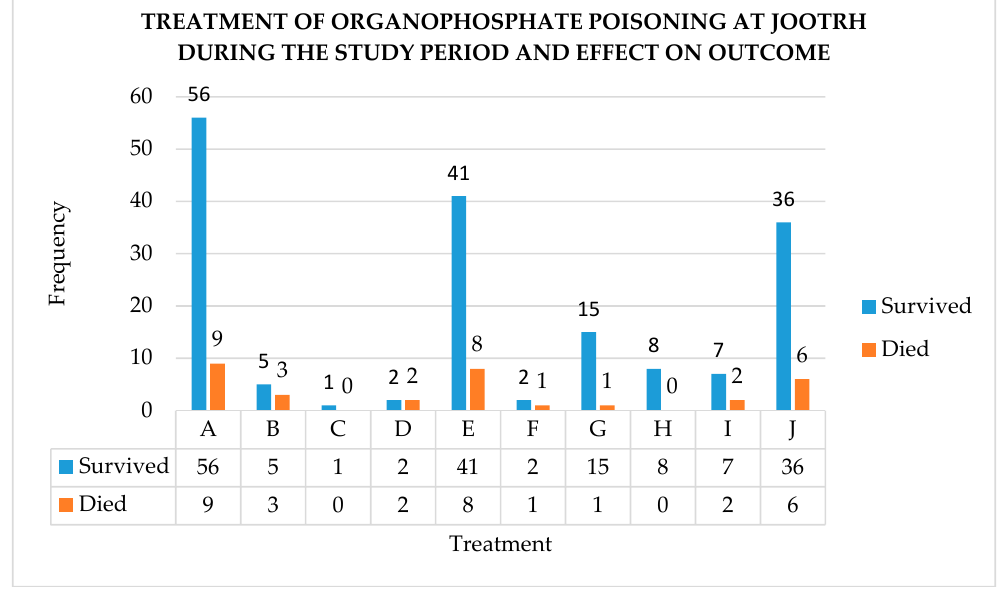
Figure 4. Frequency of use and outcome of different methods of managing organophosphate poisoning at JOOTRH, where A: supportive care (IV fluids), B: supportive care (oxygen via mask), C: supportive care (oxygen via nasal catheter), D: supportive care (methodology not specified), E: atropine, F: pralidoxime, G: atropine and pralidoxime, H: forced diuresis, I: activated charcoal, J: gastric